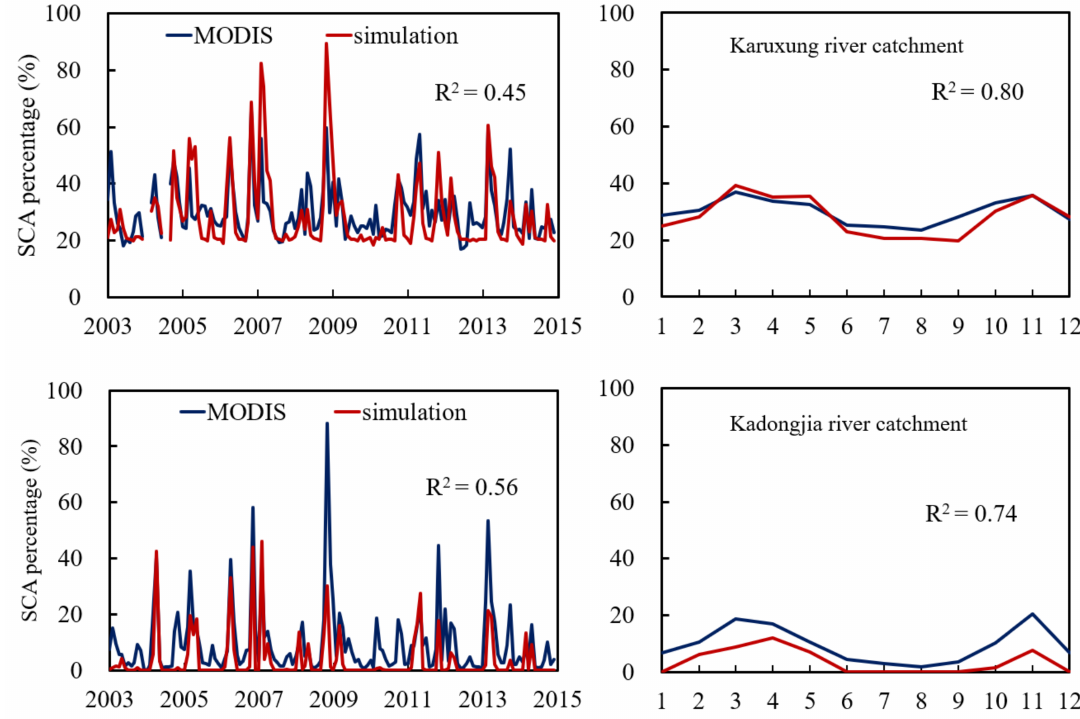
Figure 7. Monthly SCA simulation compared with MODIS data during